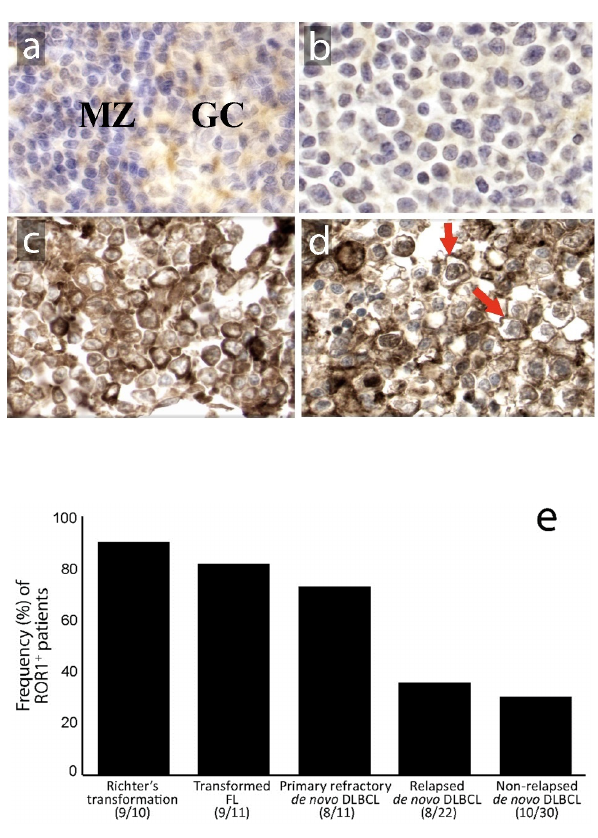
Figure 1. Expression (Immunohistochemical (IHC)) of the ROR1 protein in reactive lymphoid tissue and di ff use large B-cell lymphoma (DLBCL) lymphoma tissues. (magnification × 400; 3,3’-Diaminobenzidine (DAB) as chromogen, hematoxylin as counterstain). ROR1 was expressed ( a ) weakly in the cytoplasm of a subset of centroblasts in the germinal center (GC) and rare small lymphocytes in the mantle zone (MZ) of reactive lymph nodes; ( b ) representative case of DLBCL negative for ROR1; ( c ) DLBCL positive for ROR1 with predominantly cytoplasmic staining and ( d ) with a predominantly membranous staining pattern (red arrows); ( e ) ROR1 expression in tumor cells was more often observed in primary refractory DLBCL, Richter’s syndrome and transformed follicular lymphoma than in relapsed and non-relapsed DLBCL patients ( p < 0.001, Chi -Square test). Numbers in brackets represent the number of ROR1-positive cases compared to the total number of cases in each